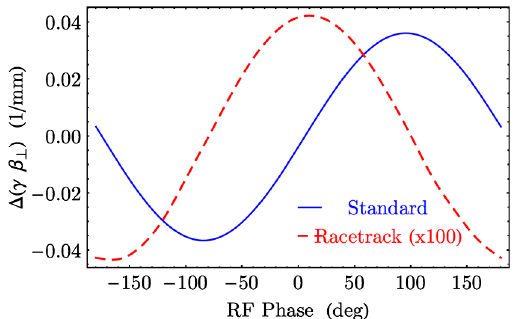
FIG. 6. Comparisonofthequadrupolekickversusrfphaseforthe Mark1 gunracetrack couplerwiththatifastandard(round)coupler had been used, normalized to 100 MV = m peak electric field. The scale for the racetrack coupler has been magnified by 100